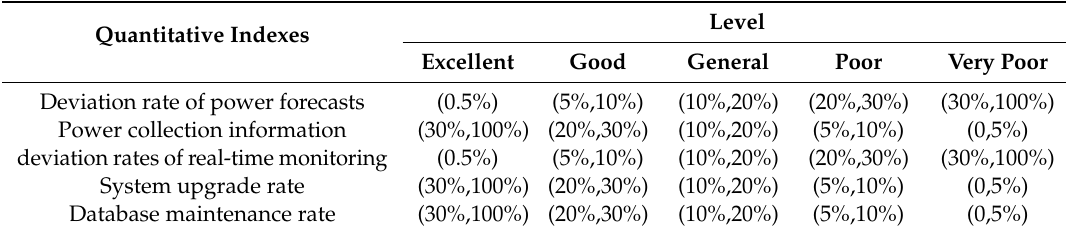
Table 6. Score intervals of quantitative indexes.